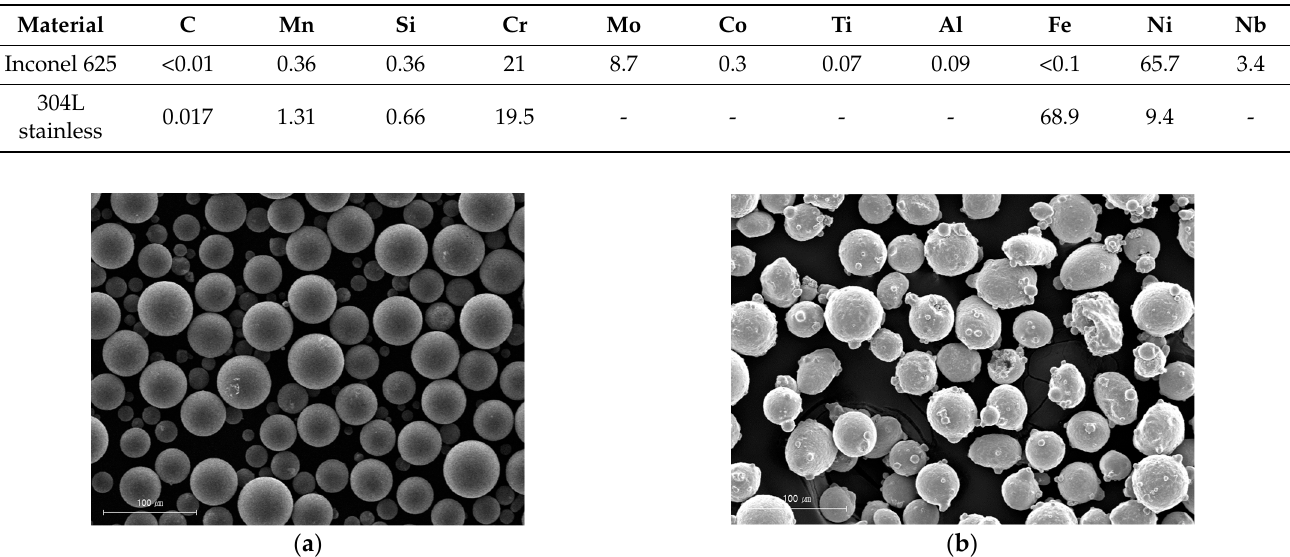
Table 1. Chemical compositions of Inconel 625 and 304L stainless powders [wt. %].